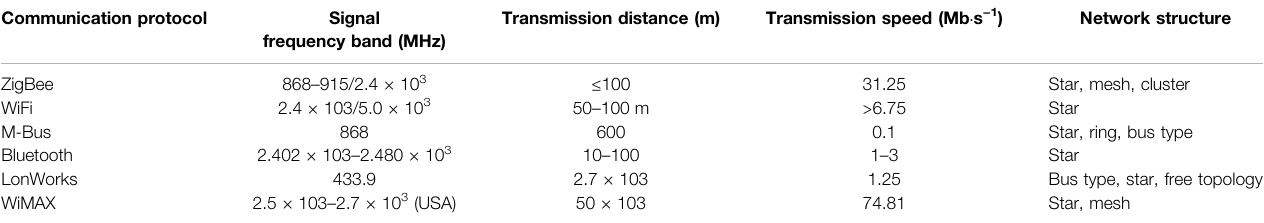
TABLE 2 | Comparison of wireless communication techniques. Communication